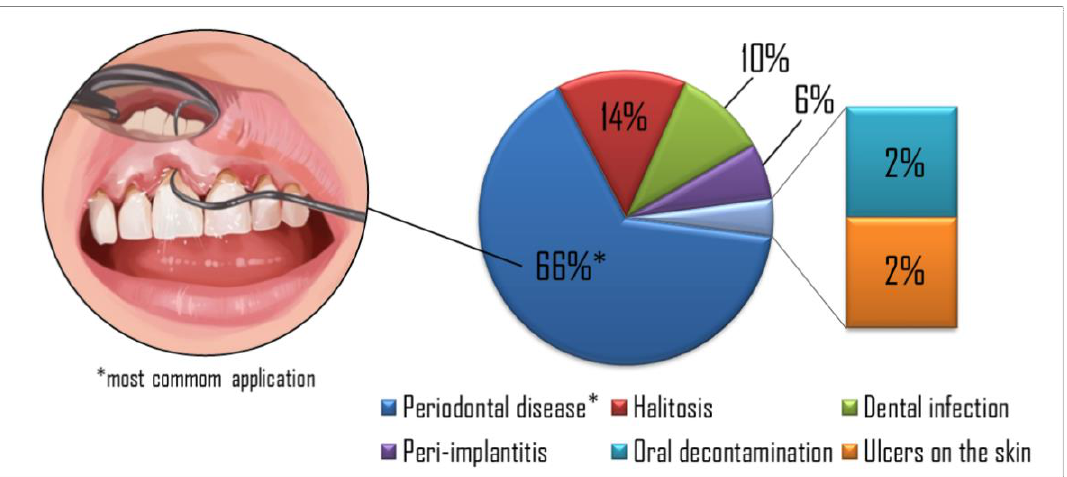
Figure 2. The percentage of targets in the papers reviewed showed periodontal disease as the most common application found in the studies, followed by halitosis, dental infection, peri-implantitis, oral decontamination, and skin ulcers,